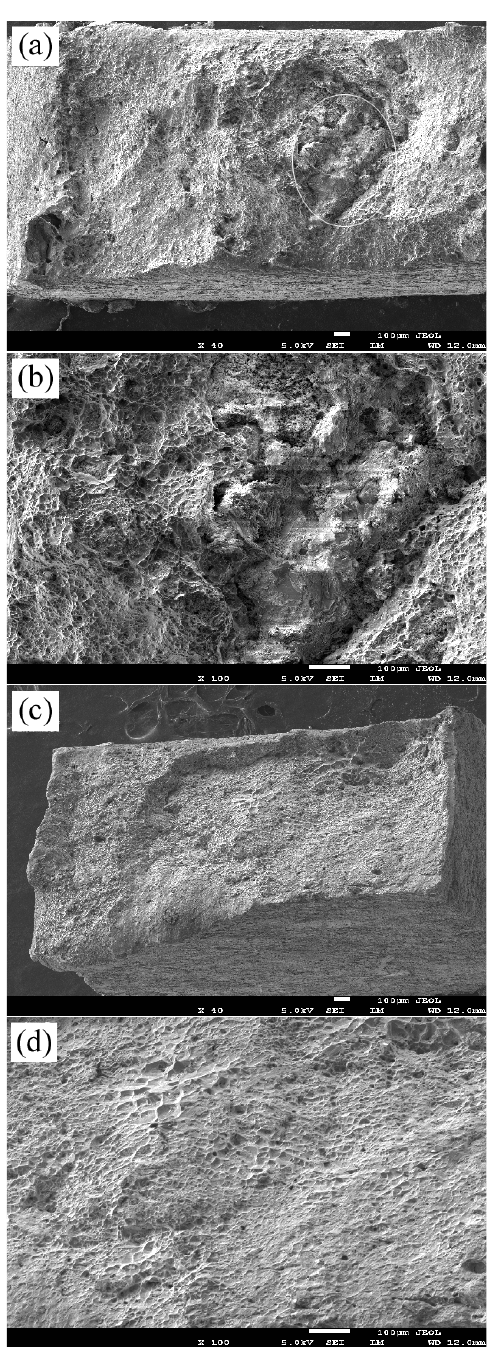
Figure 13: The tensile fractures of TiB 2 /Al composites prepared by (a)(b) LSM and (c)(d) electroslag